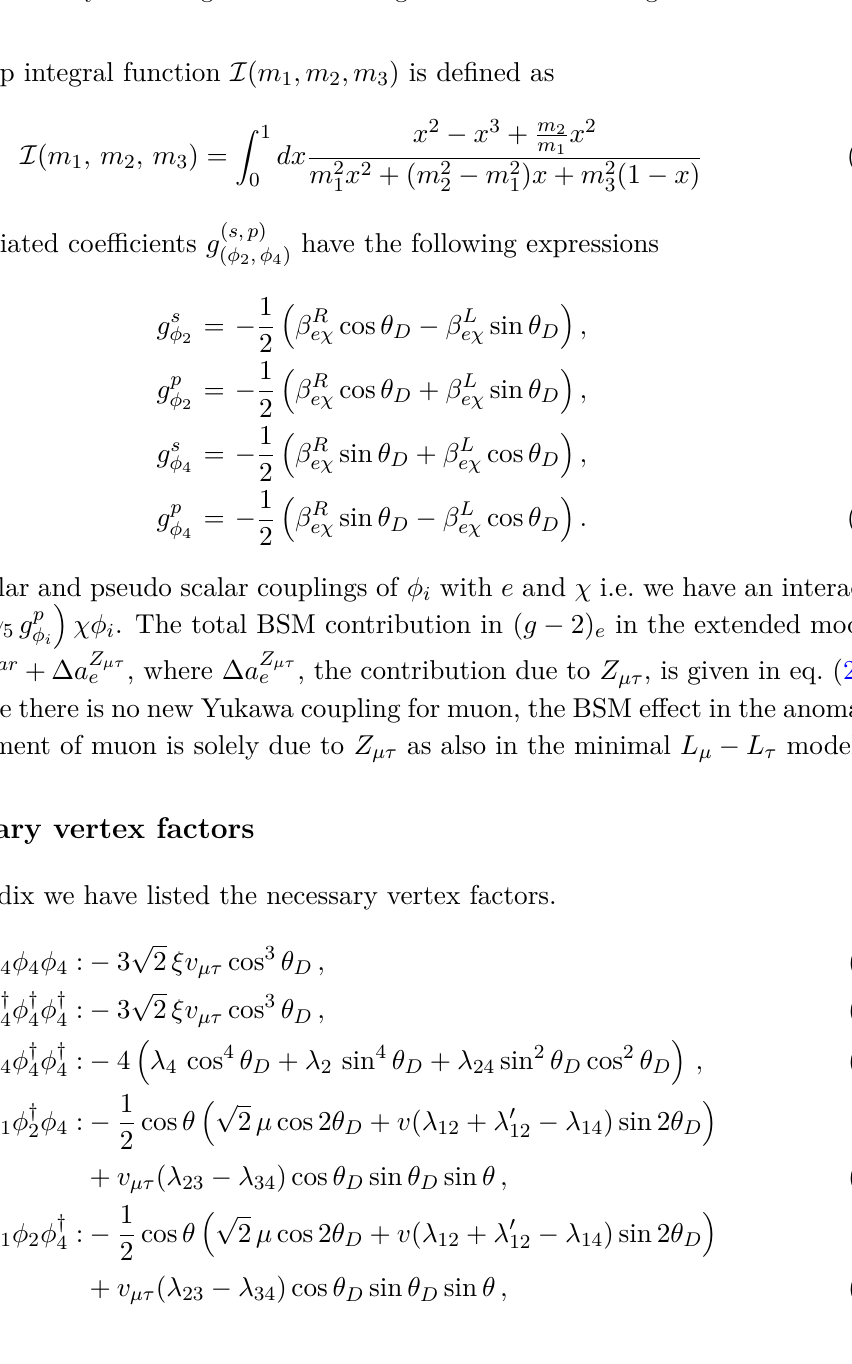
Figure 16 . Feynman diagrams contributing to the anomalous magnetic